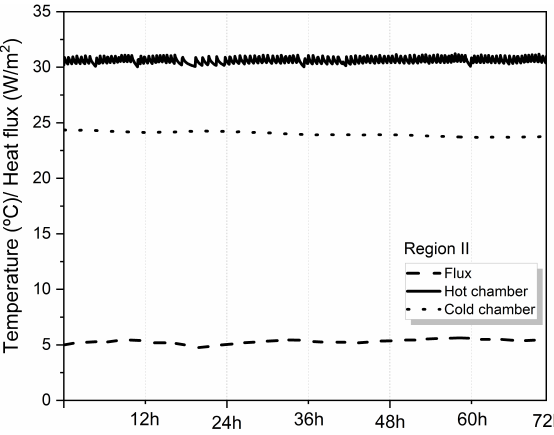
Figure 5. Region I reed board prototype: tempera- tures and heat flow.